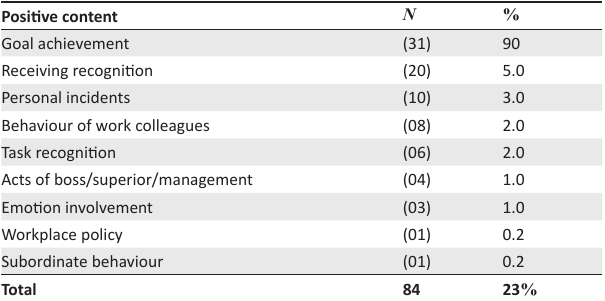
TABLE 1a: Categories of emotion episodes experienced with a positive content ( N = 358).